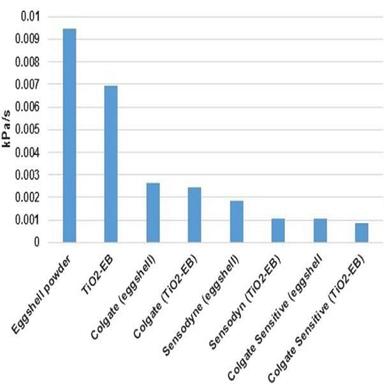
Mean slope differences between eggshell and TiO2-EB showing acid resistant properties TiO2-EB.